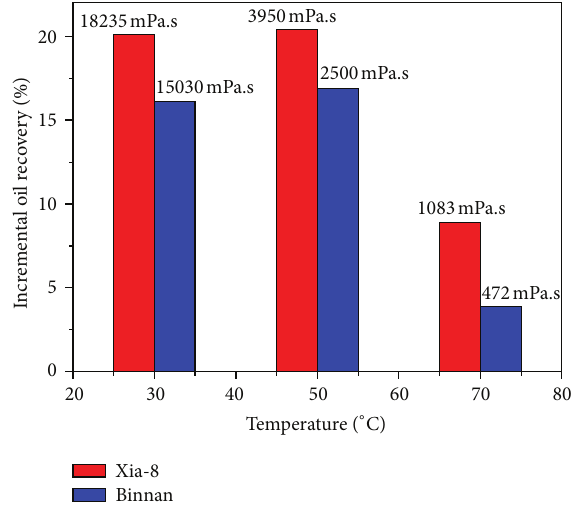
Figure 6: Influence of oil viscosity on the alkaline flooding effi- ciency.